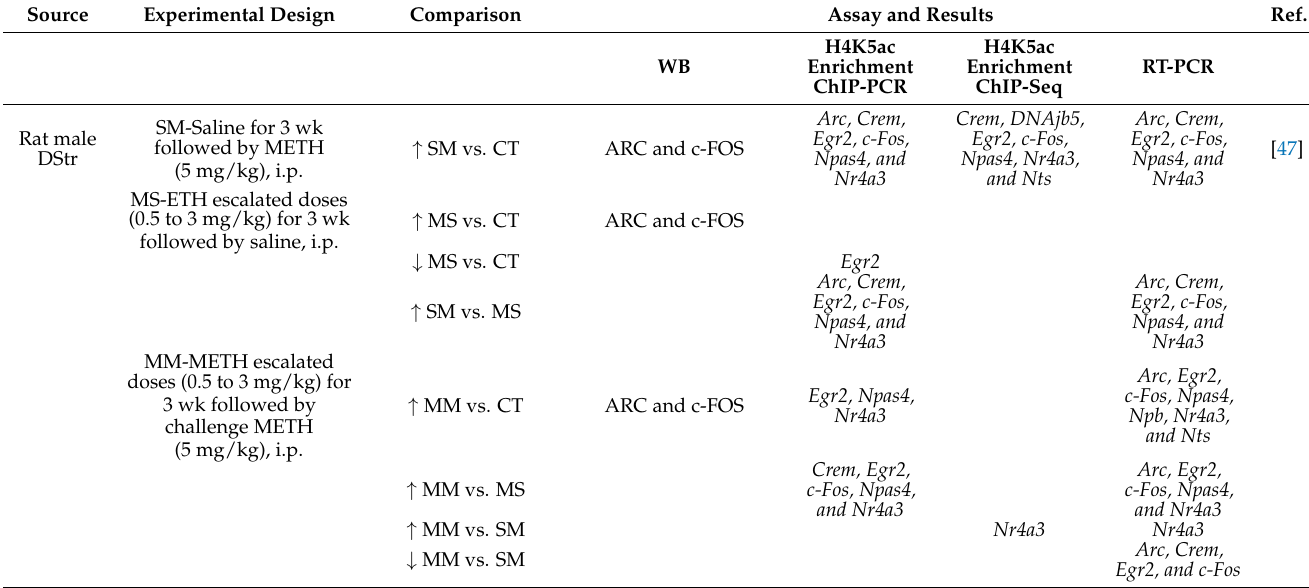
Table 1. Histones modifications affected by METH